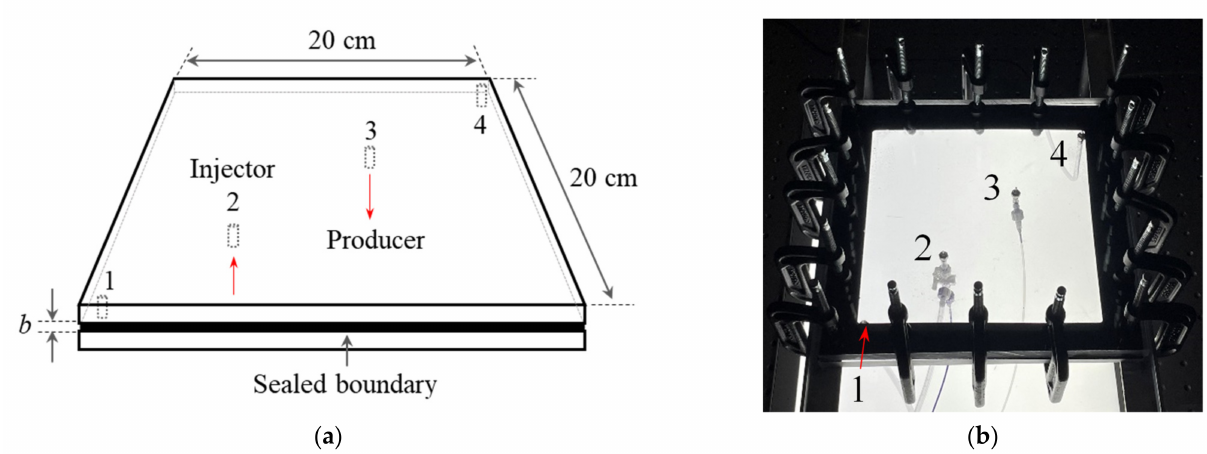
Figure 1. Experimental setup. Note four wells are located on the lower plate. ( a ) Schematic of view area of a Hele–Shaw cell. ( b ) Actual Hele–Shaw cell